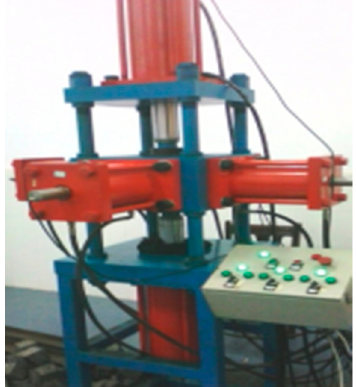
Figure 1. Self-developed true triaxial test machine.